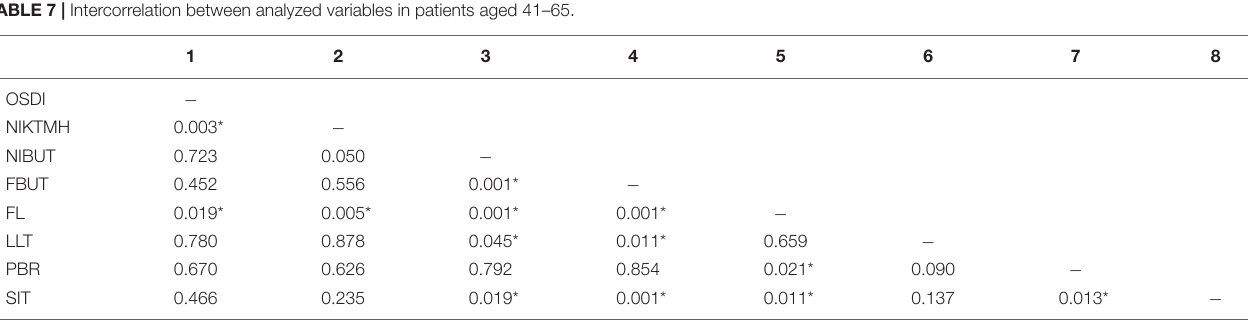
TABLE 7 | Intercorrelation between analyzed variables in patients aged 41–65.